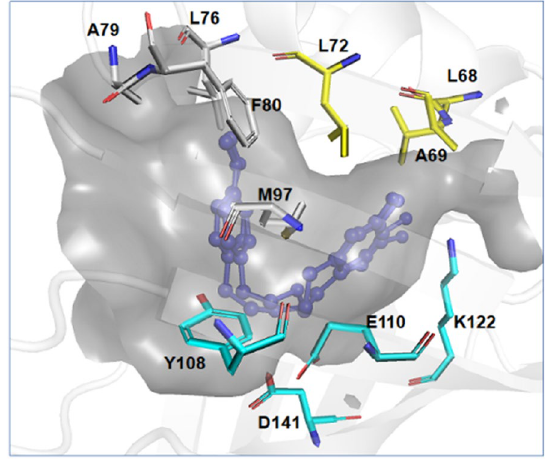
Fig. 3 The substrate‑binding pocket of Tf NCS (PDB ID: 5NON). Catalytic residues and the product mimic are coloured cyan and blue, respectively. Residues around the aldehyde substrate and the hydroxyl group of the amine substrate are coloured white and yellow,